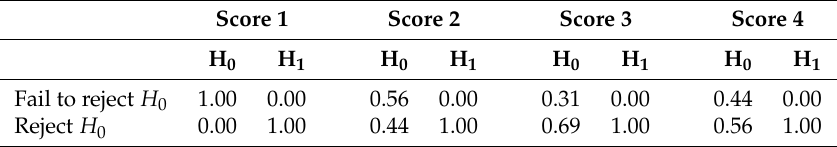
Table 13. True rate of false positives and false negatives for each of the four scores when the size of the samples to diagnose is ν = 50 and the sensors used are numbers 1,2,4,5,6 and 7.